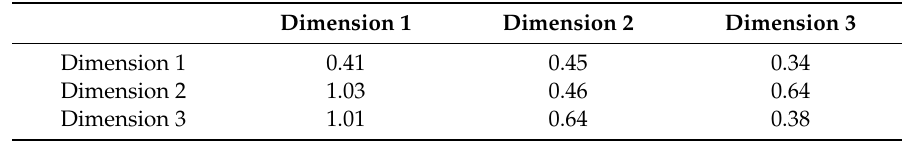
Table 3. Total relation matrix for the dimensions.